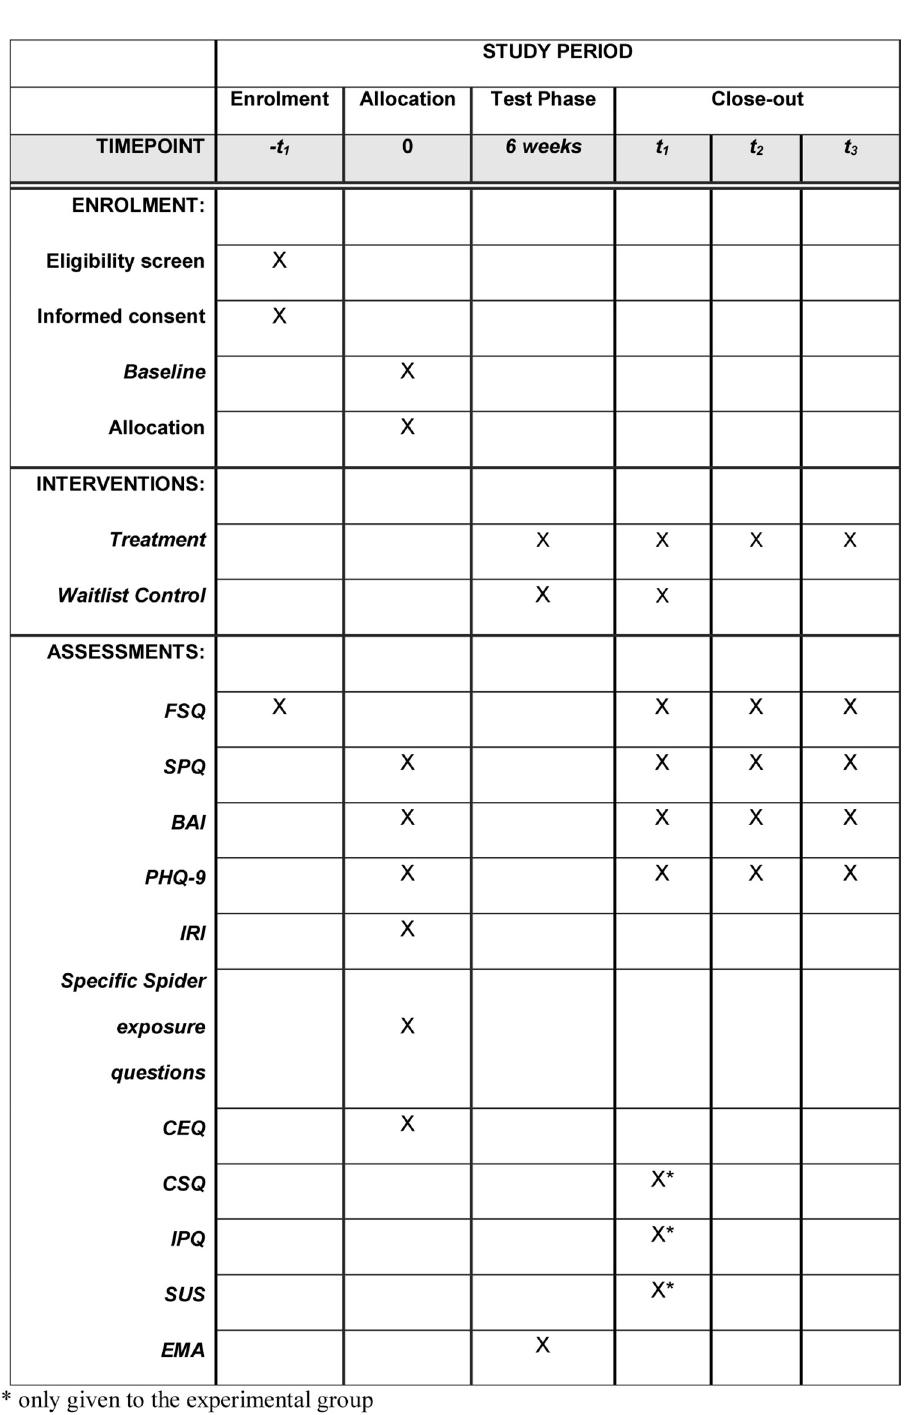
Fig 1. Standard Protocol Items: Recommendations for Interventional Trials (SPIRIT) schedule of enrollment, interventions, and assessments.